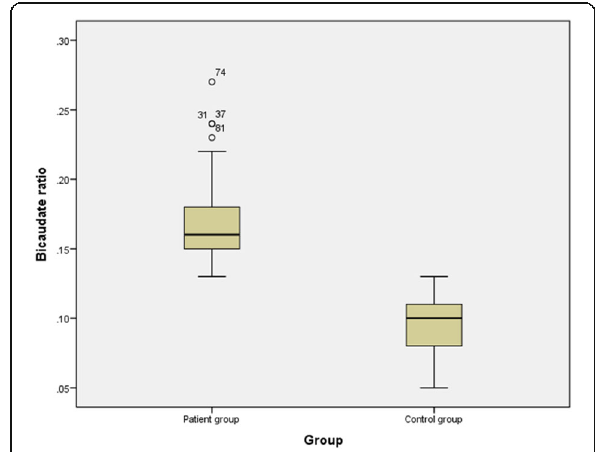
Fig. 4 Box plot showing the BCR values for both patients and